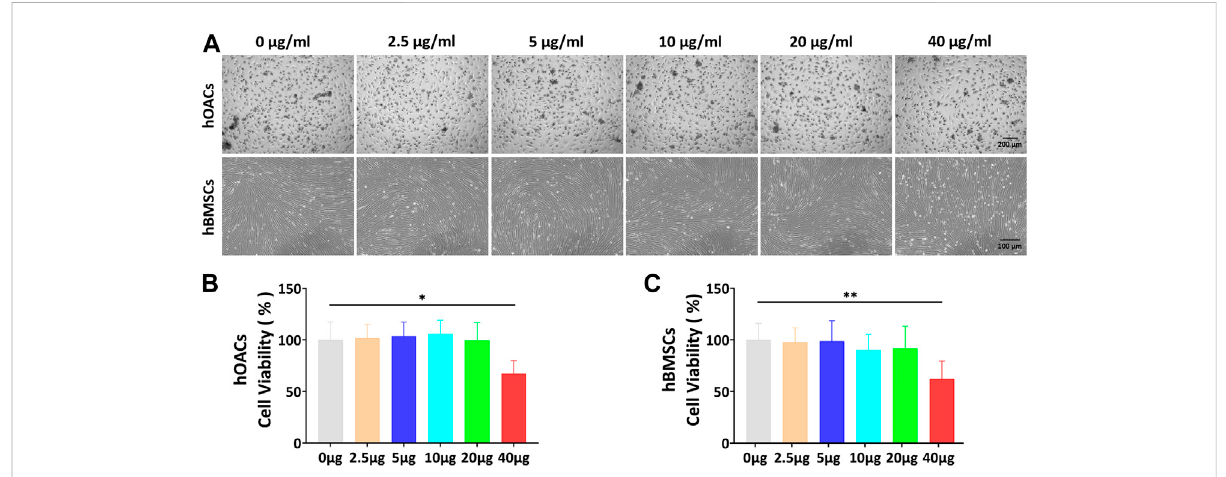
FIGURE 3 In vitro Ept concentration screening for hOACs and hBMSCs treatment. (A) Optical microscopy observation of Ept in fl uenced cell viability in hOACs and hBMSCs. (B and C) The quantitative analyses of Ept in fl uenced cell viability in hOACs and hBMSCs ( n = 6). Mean ± SD, p * < 0.05, p ** <